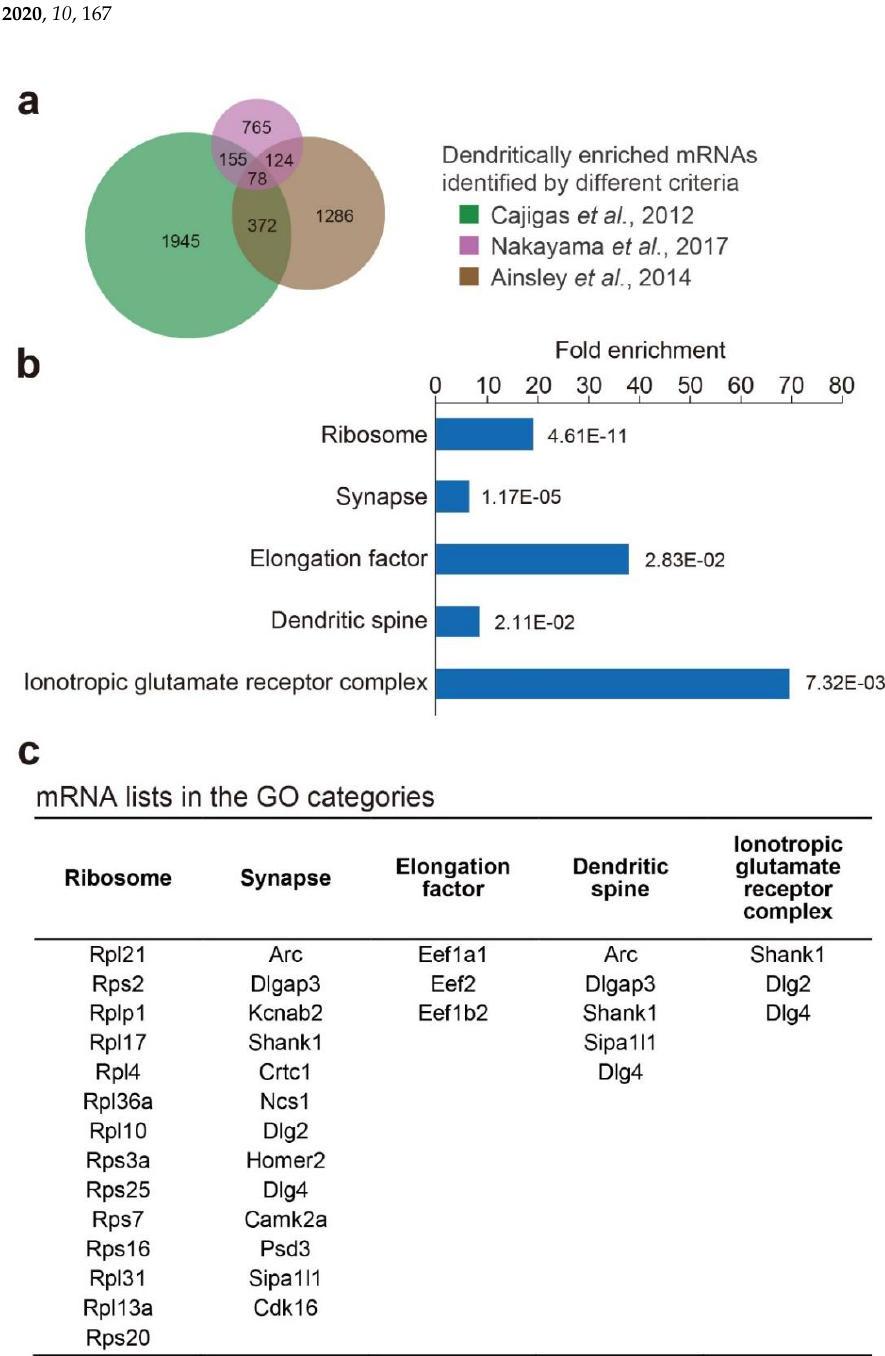
Figure 2. Gene ontology (GO) categories in which the identified dendritic mRNAs were enriched. The three studies (Cajigas et al. 2012; Ainsley et al, 2014; Nakayama et al., 2017) were compared, and 78 mRNAs were found to be commonly identified in the studies ( a ). The 78 mRNAs were classified by GO enrichment analysis using DAVID 6.8. GO categories in which the mRNAs were significantly enriched ( b ), and the list of mRNAs included in the GO categories ( c ) are